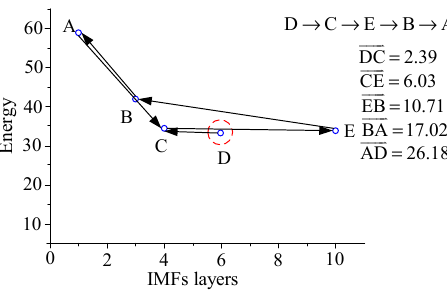
Figure 12. Shortest path of start node C.